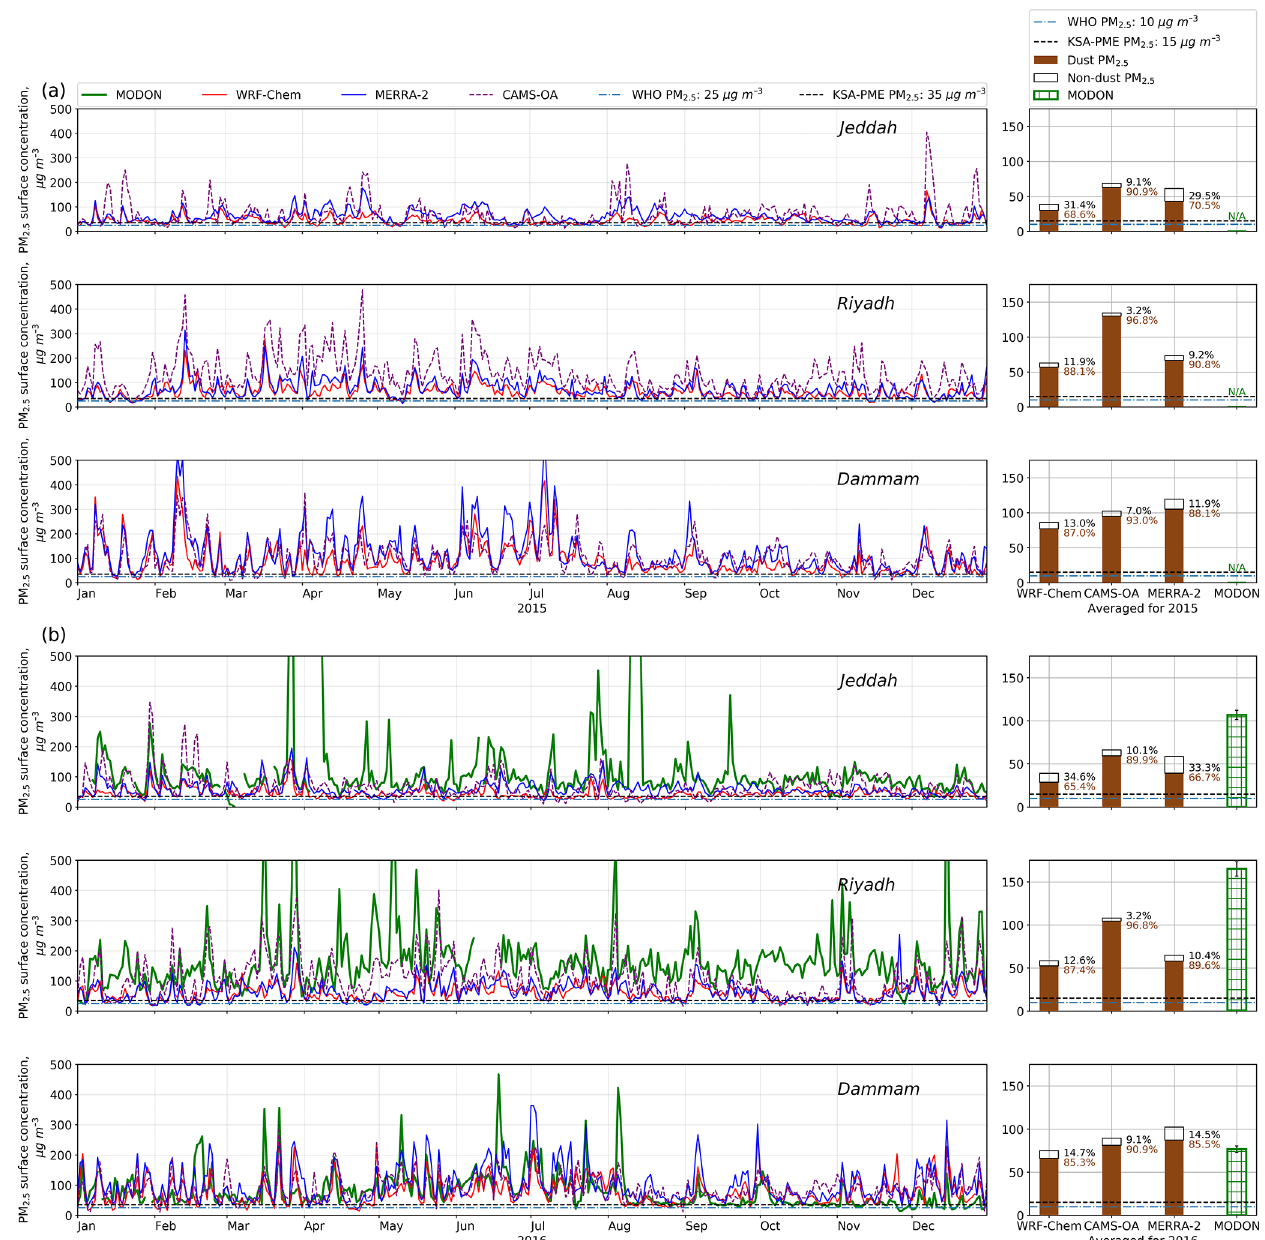
Figure 8. Left: WRF-Chem daily averaged PM 2 . 5 surface concentrations (µgm − 3 ) with MODON observations, MERRA-2, and CAMS-OA at Jeddah, Riyadh, and Dammam. The dash-dotted line corresponds to the 25µgm − 3 WHO daily average guideline. Right: stacked bars show the decomposition of the PM 2 . 5 annual mean surface concentrations into dust and nondust components. The dash-dotted line corresponds to the 10µgm − 3 WHO annual guideline. Numbers on the right-hand side of the WRF-Chem, CAMS-OA, and MERRA-2 bars show the contribution (%) of the dust and nondust components to the total PM 2 . 5 concentration. (a) 2015, (b)